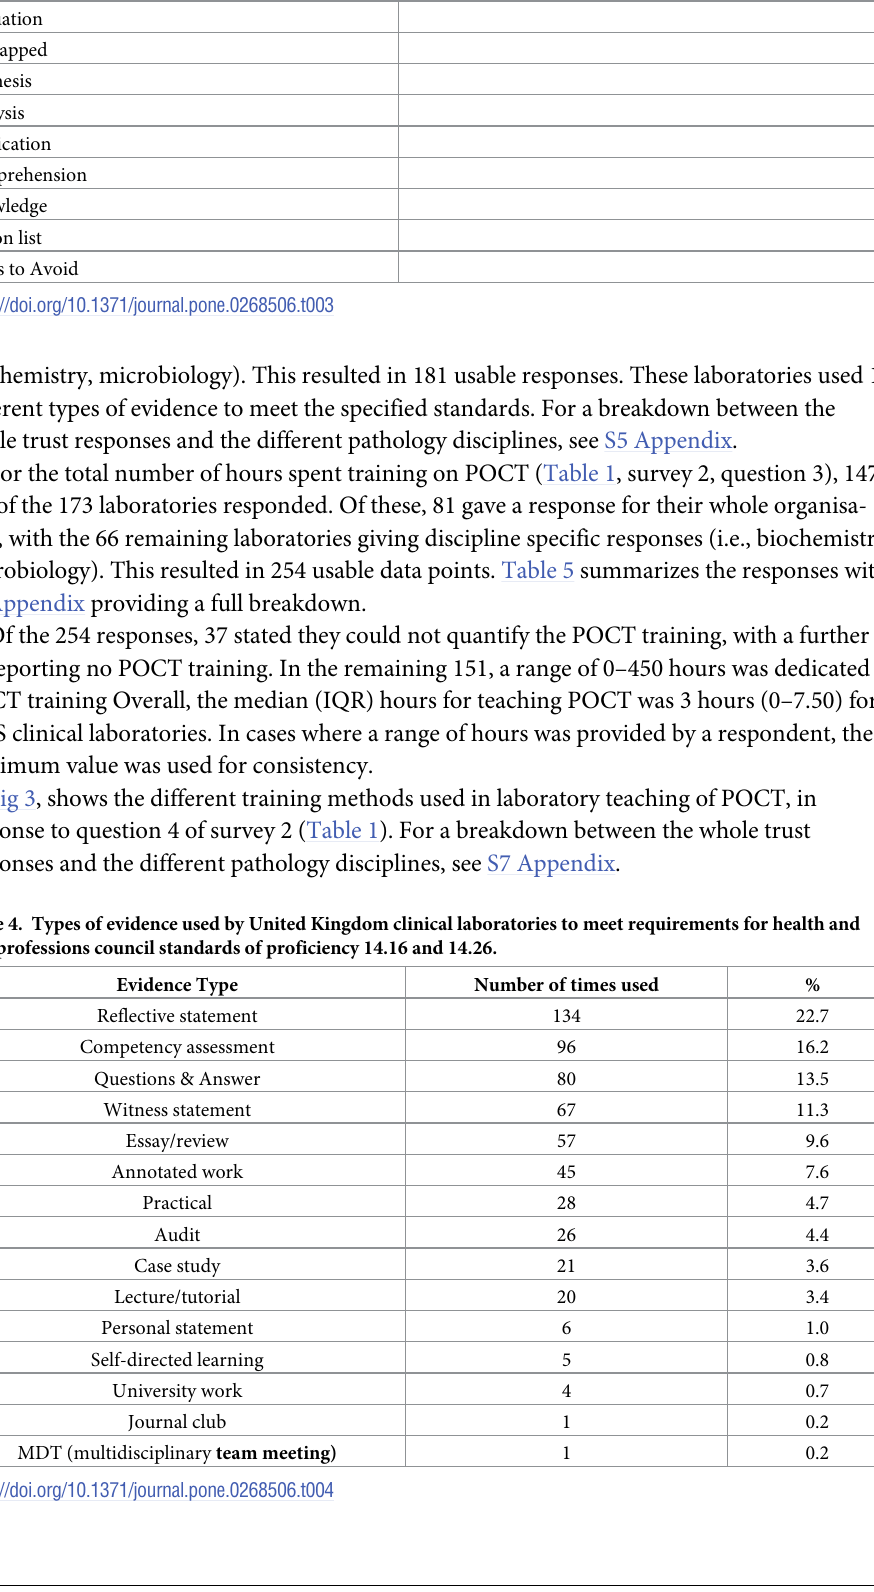
Table 3. Action verbs mapped to level of Bloom’s taxonomy. The verbs were assigned using the lists collated by Newton et al. [28]. level of blooms taxonomy Count of verbs assigned to level